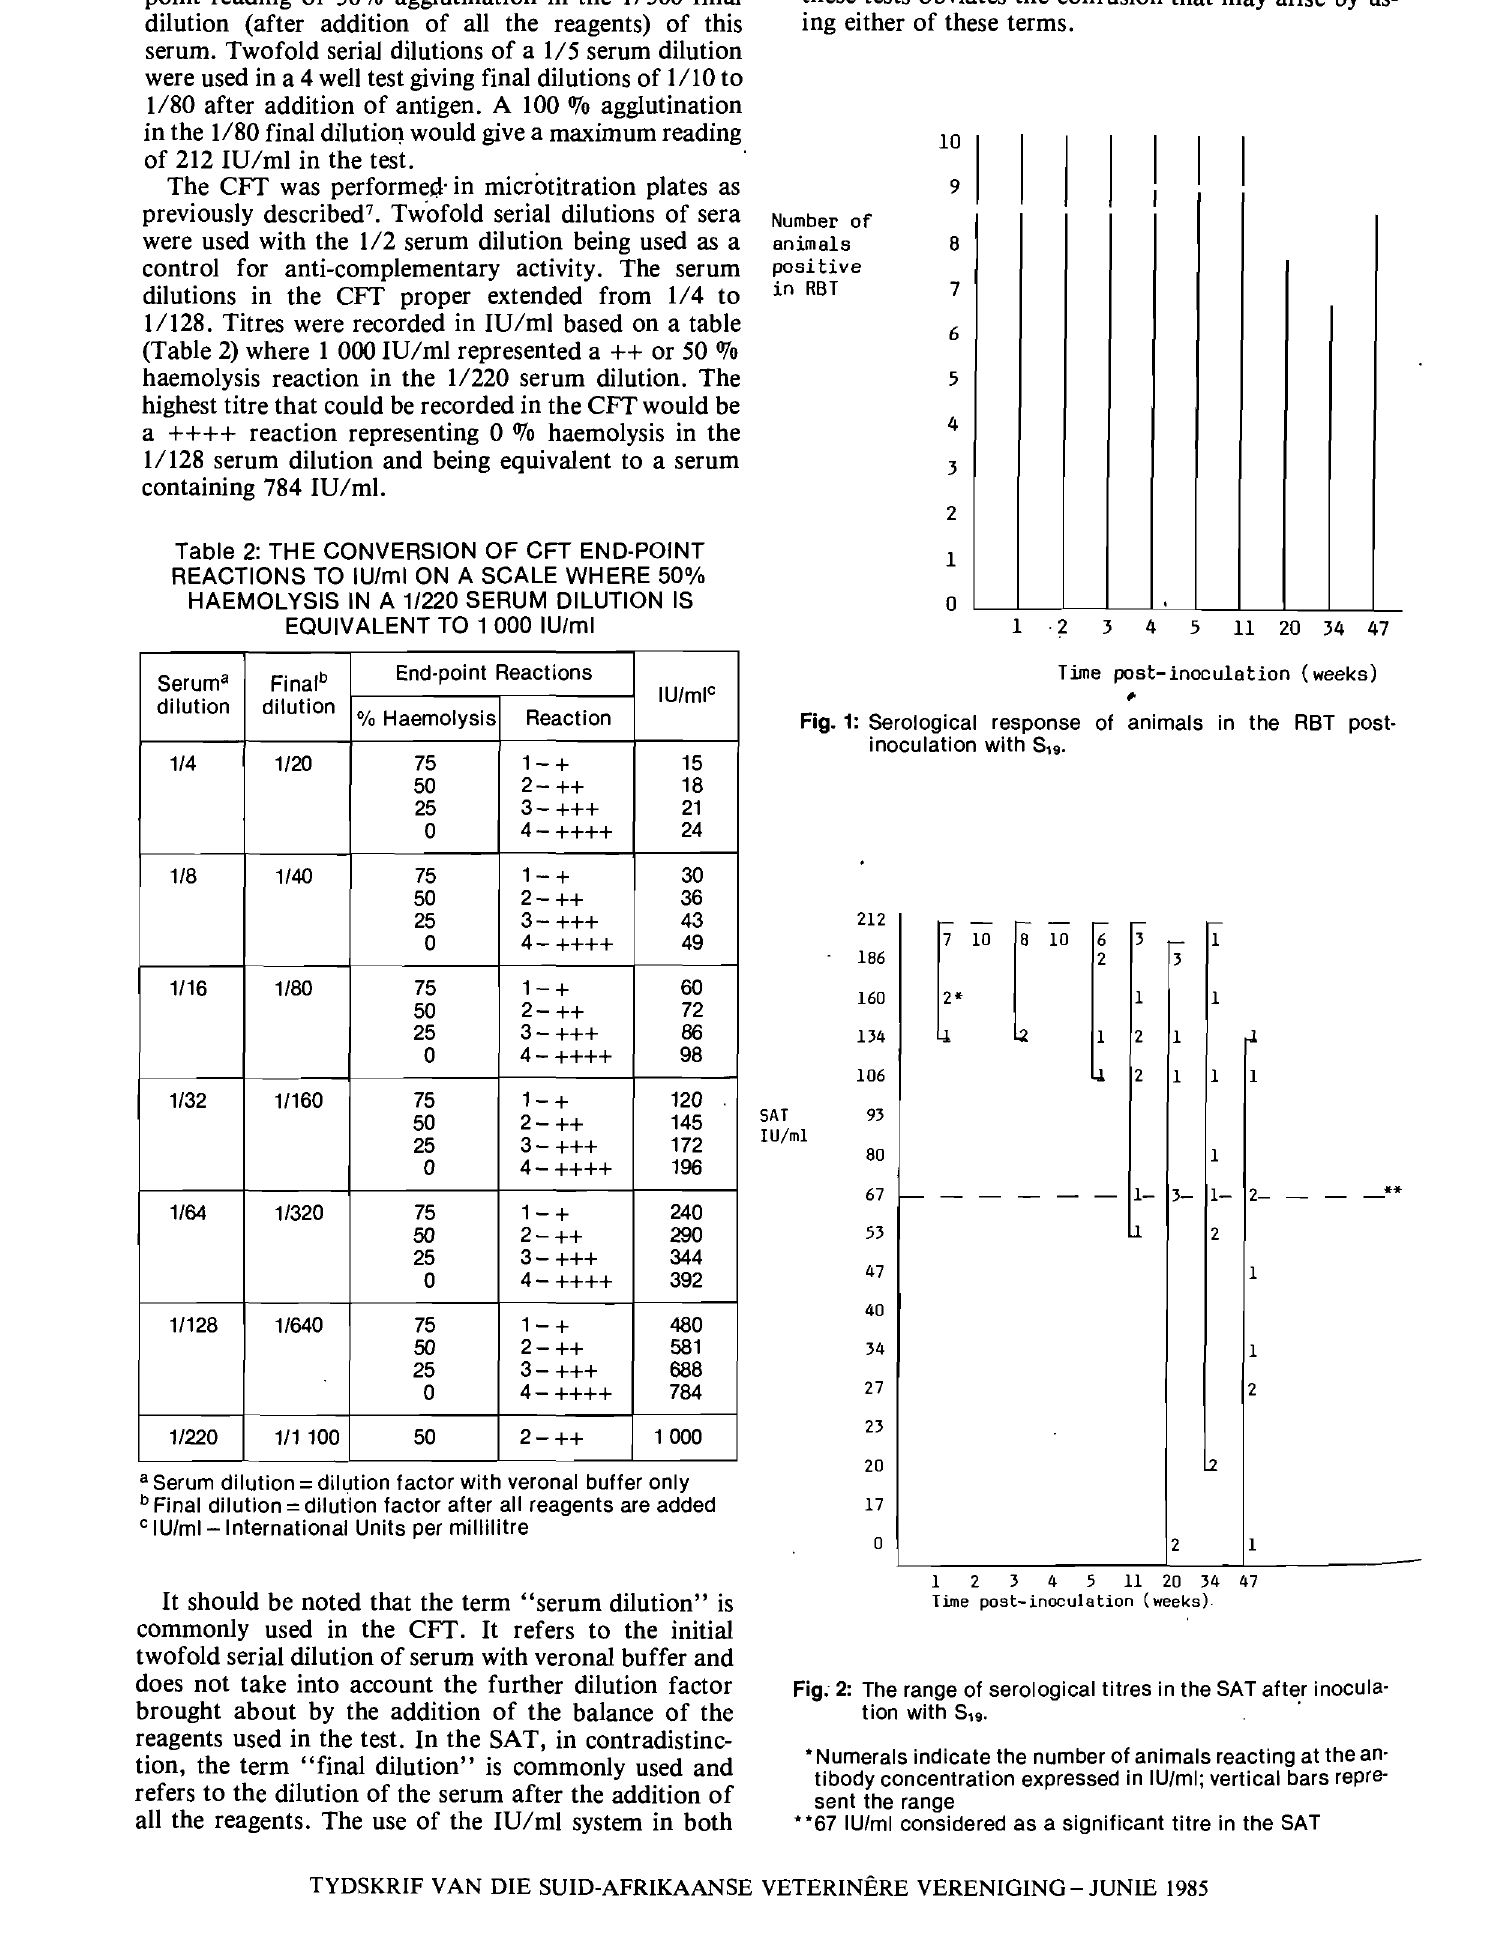
Fig; 2: The range of serological titres in the SAT after inocula· tion with S'9. . * Numerals indicate the number of animals reacting at the an· tibody concentration expressed in IU/ml; vertical bars